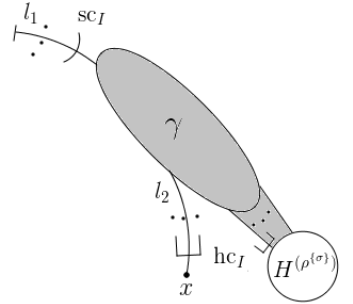
Figure 9. The subgraph (cid:13) , which includes the propagators marked by momentum l (cid:22) the shaded area. The hard-collinear and soft-collinear approximations are from t (cid:27) .